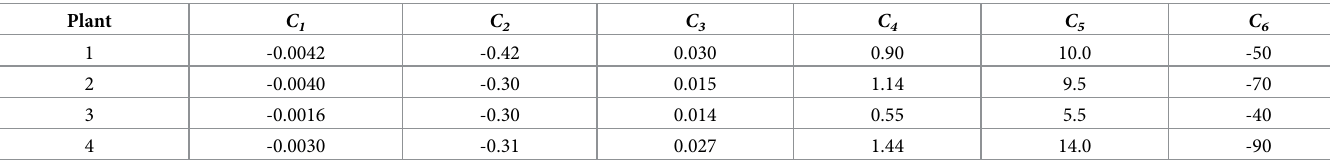
Table 4. Hydropower generation